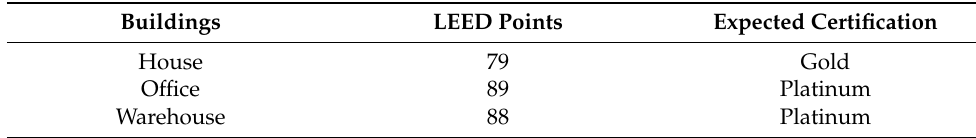
Table 11. Certification of the tested